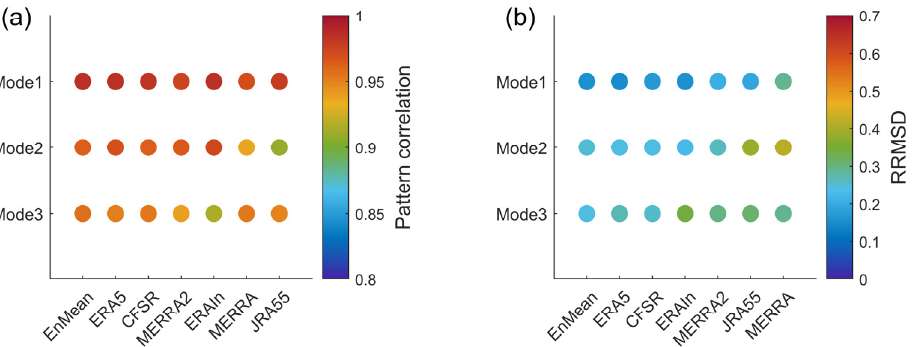
Figure 5. The spatial pattern correlation coefficients ( a ) and RRMSD ( b ) between reanalysis and observational spatial patterns at the station locations for the leading three modes of annual CMCA. The horizontal axis is sorted by the sum of the PatCor (RRMSD) of the first three modes from the smallest (largest) to the largest (smallest).